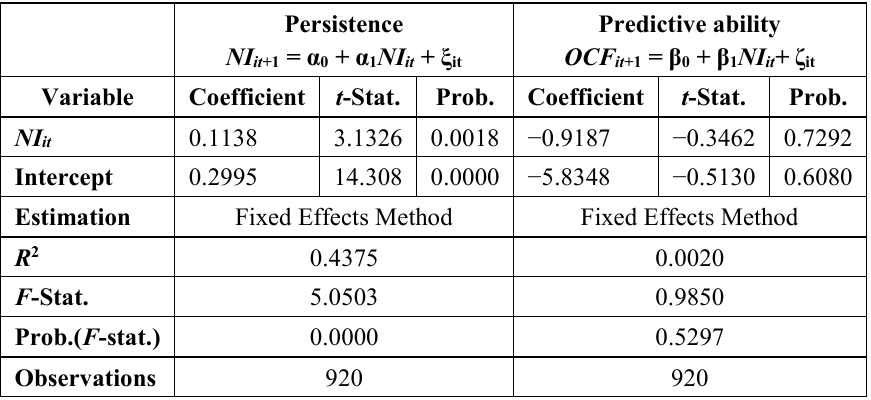
Table 3. The Model Estimation Results in French